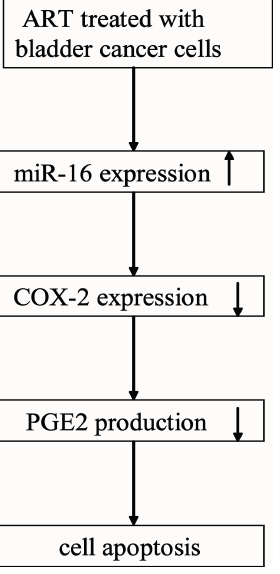
Figure 8. Diagram depicting the mechanism of ART induced bladder cancer cells apoptosis. The arrow of “ ↑ ” means increase and the arrow of “ ↓ ” means